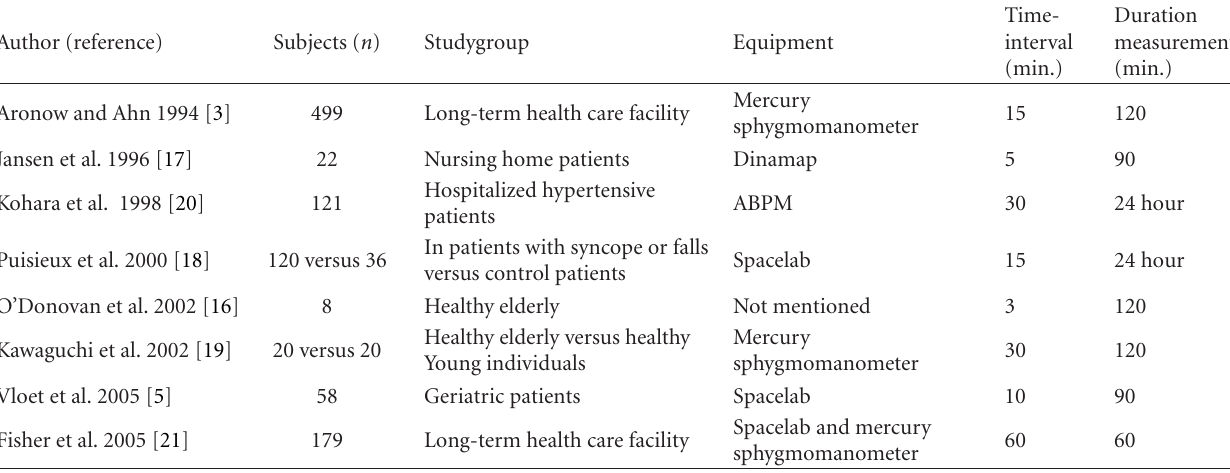
Table 1: Methods used to measure postprandial hypotension.